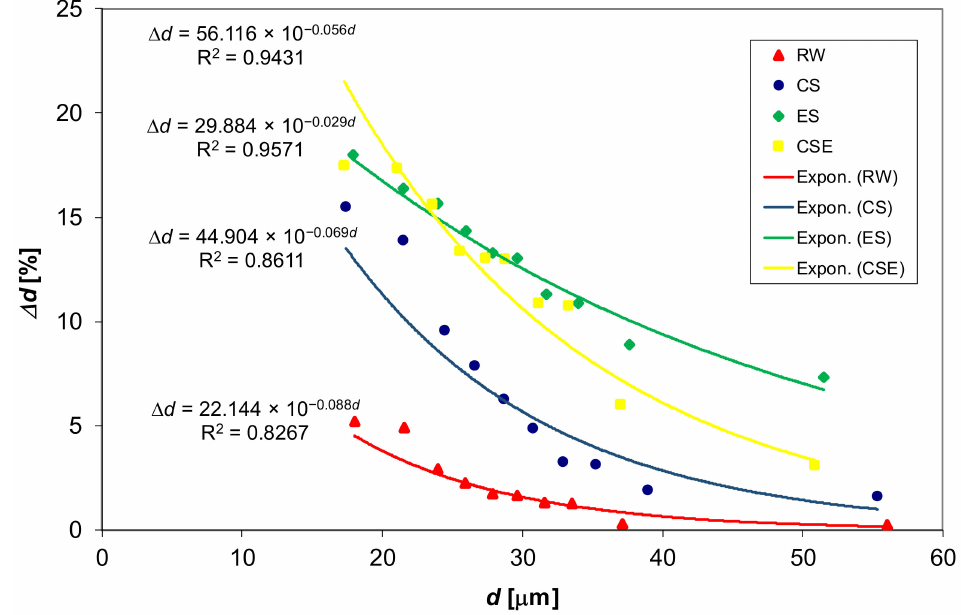
Figure 2. Degree of swelling raw and scoured wool in